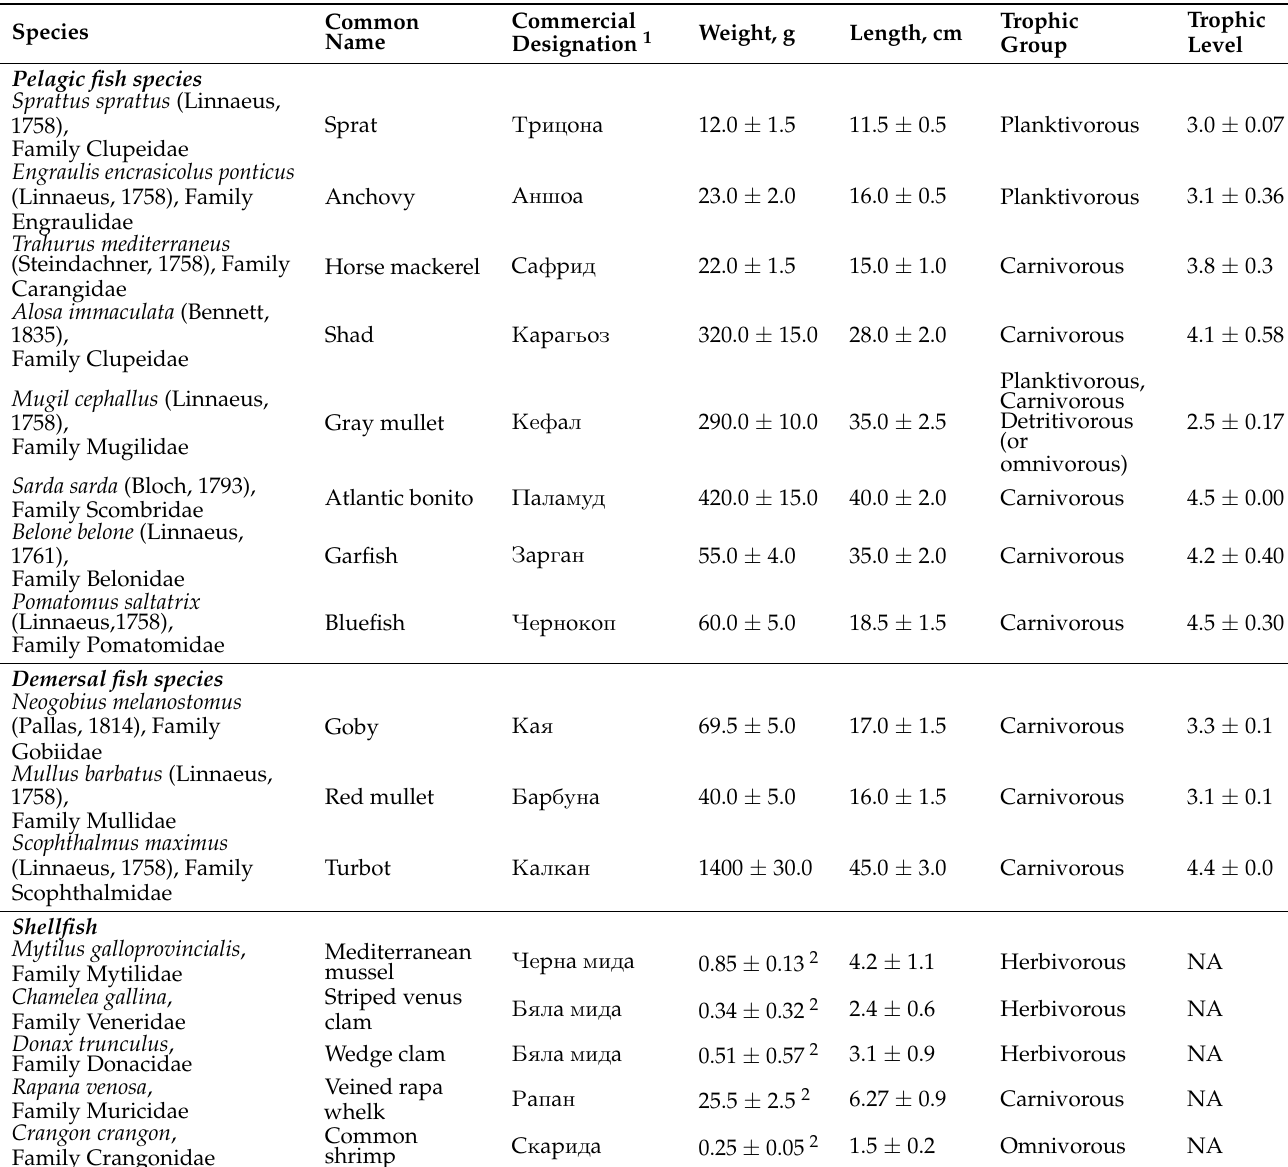
Table 1. Scientific names, commercial designations (in Bulgarian), biometric data (mean ± SD), trophic groups, and trophic levels (for the fish